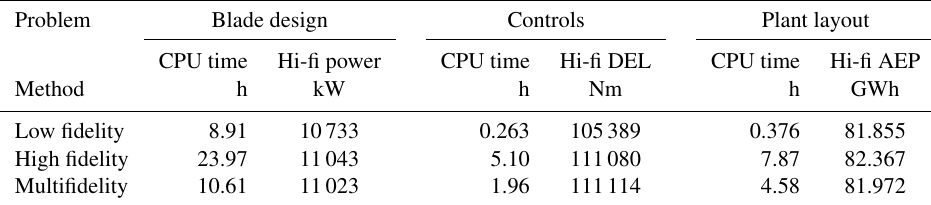
Table 7. Each case is summarized here, showing the multifidelity method takes less computational time than the high-fidelity-only optimiza- tion while finding improved designs compared to the low-fidelity-only